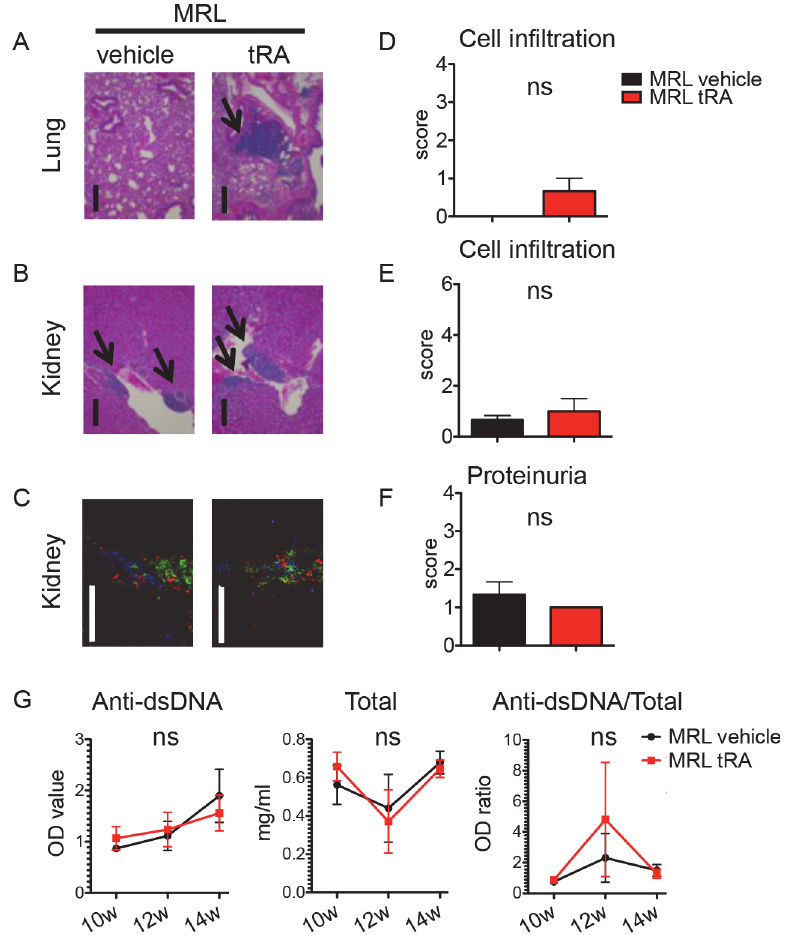
Fig 7. Minimal induction of inflammation with tRA in the absence of an immunogenic environment. MRL mice were given, orally and daily, vehicle (canola oil) or tRA (6 mg/kg BW) from 6 to 14 weeks of age when tissues were collected. n = 3 mice in each group. (A) H&E stains of the lung. Representative micrographs are shown. Bar equals 400 μ m. Areas of infiltration are indicated by arrows. (B) Representative micrographs of H&E stains of the kidney. Bar equals 400 m. (C) Immunohistochemical stains of T cells (CD3- green), dendritic cells (CD11c-red), and plasma cells (CD138-blue). Representative images are shown. Bar equals 200 μ m. (D-E) Leukocyte infiltration scores of the lung (D) and kidney (E) according to H&E stains. (F) Analysis of proteinuria. The level of total protein in the urine of 14-week-old mice was measured with Chemstrip 2GP. (G) Anti-dsDNA IgG, total IgG, and their ratios in the plasma of 10-, 12- and 14-week-old mice as determined by respective ELISA. ns: not significant, student ’ s t -test. Data are shown as mean + SEM or mean ±